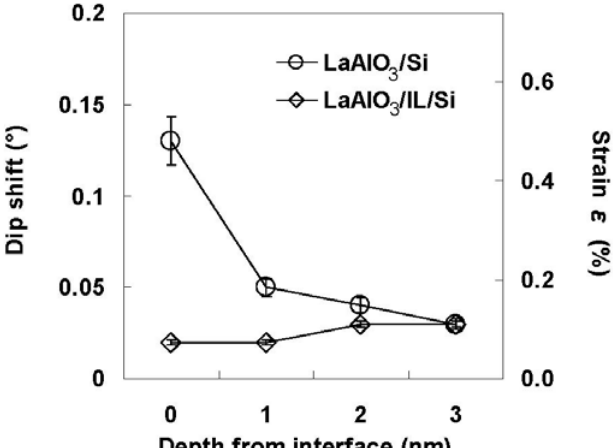
Figure 18. Depth dependence of the strain at the SiO annealed in an oxygen ambient. The data for the as-deposited specimen is shown again for